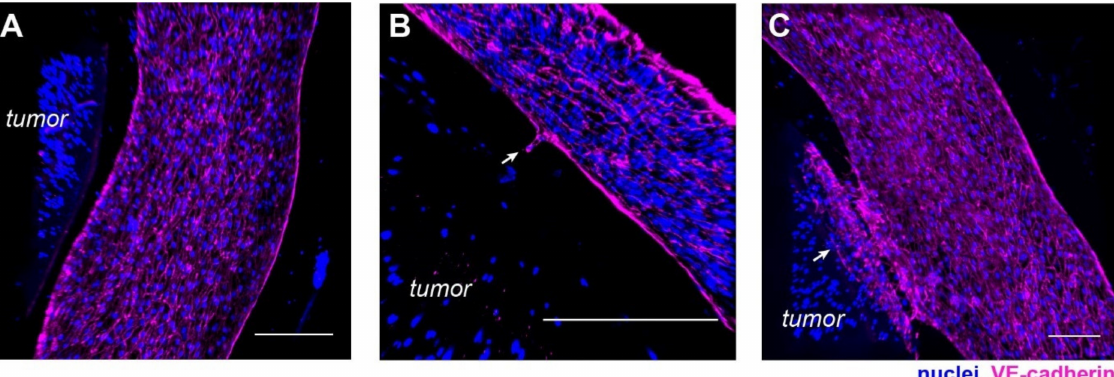
Figure 5. Angiogenesis in a hypoxic SKOV3 tumor model. ( A ) A vascular segment without angiogenic activities in early culture. ( B ) Vascular sprouting toward the tumor section on day 5. ( C ) Massive endothelial ingrowth into the tumor section in one vascular segment on day 7. Scale bars: 250 µ